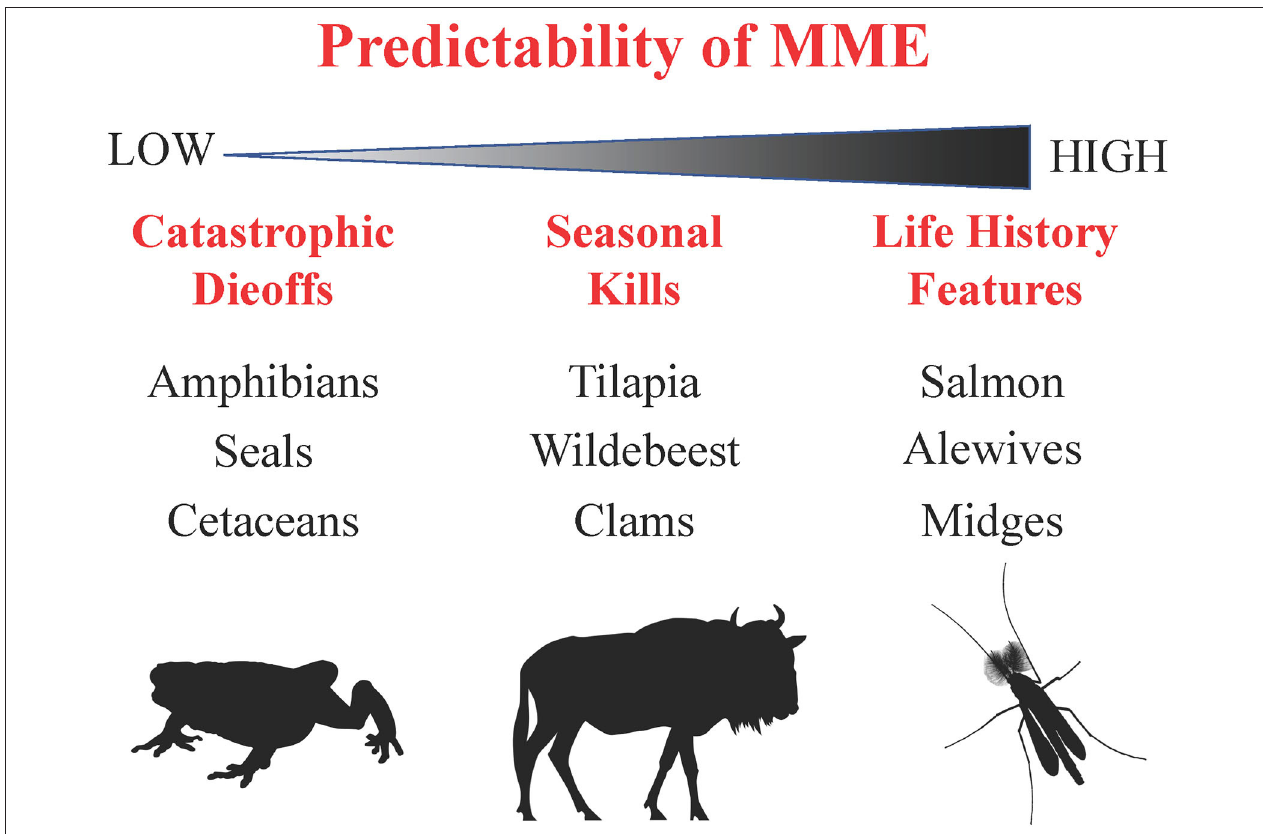
FIGURE 2 | Conceptual diagram depicting a predictability gradient of mass mortality events, and therefore possible ecosystem effects, ranging from catastrophic die-offs (left-hand side) to programmed death (right-hand side) with example